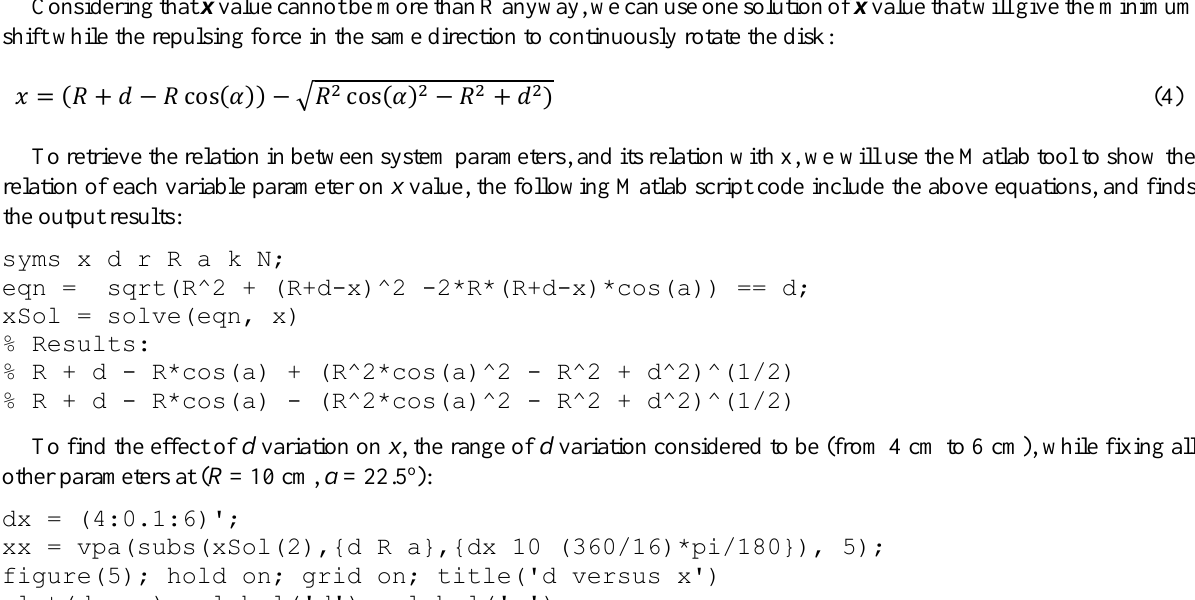
figure(6); hold on; grid on; title('R versus x')